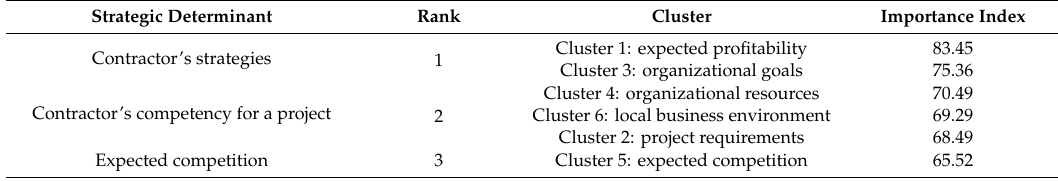
Table 5. Ranks of strategic determinants of BNB decision-making during economic